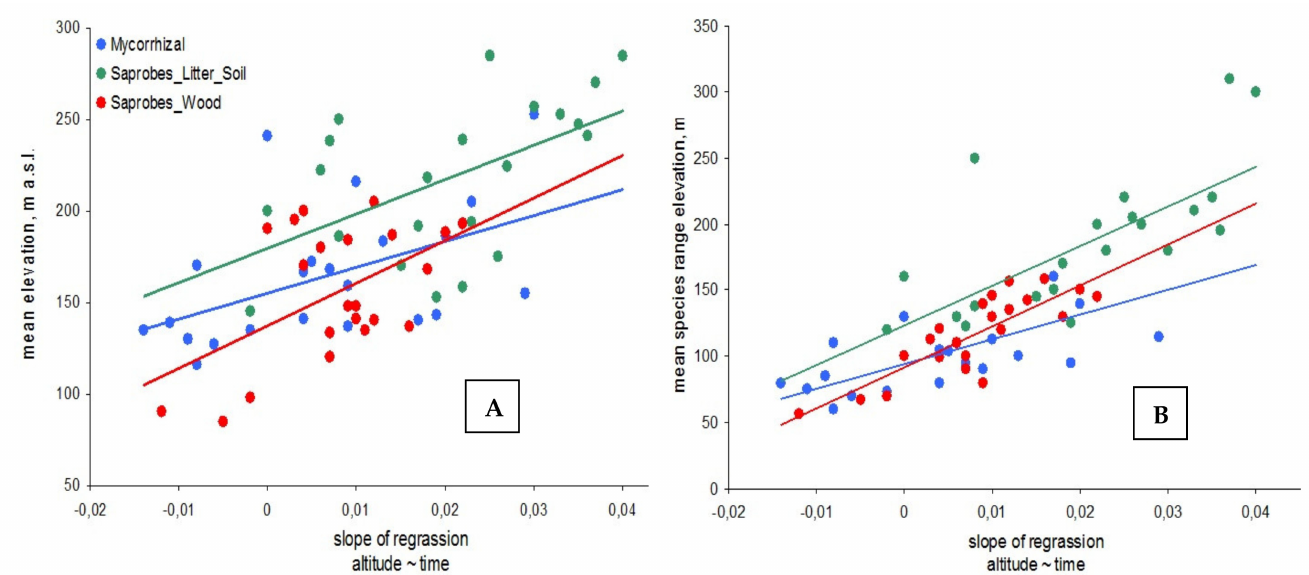
Figure 4. Species relationships between the altitude trend over time and mean fruiting elevation ( A ) of 1960 to 2020, and their altitudinal range ( B ). This shows how much the species move up or down on mean elevation (moving up if the slope is greater than 0, and down if the slope is <0). ( A ): saprobes on litter and soil (green circles; r = 0.54, p = 0.47), saprobes on wood (red; r = 0.47, p = 0.44) and ectomycorrhizal species (blue; r = 0.25, p = 0.29; ( B ): saprobes on litter and soil (green circles; r = 0.60, p = 0.56), saprobes on wood (red; r = 0.52, p = 0.61) and ectomycorrhizal species (blue; r = 0.22, p =